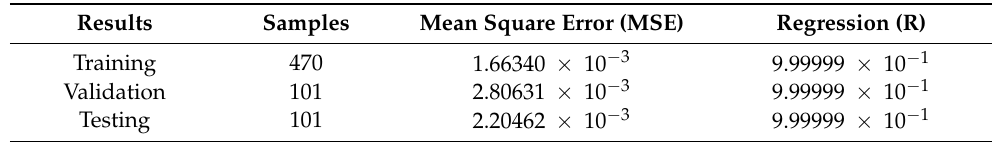
Table 1. Results of tuning ANN of